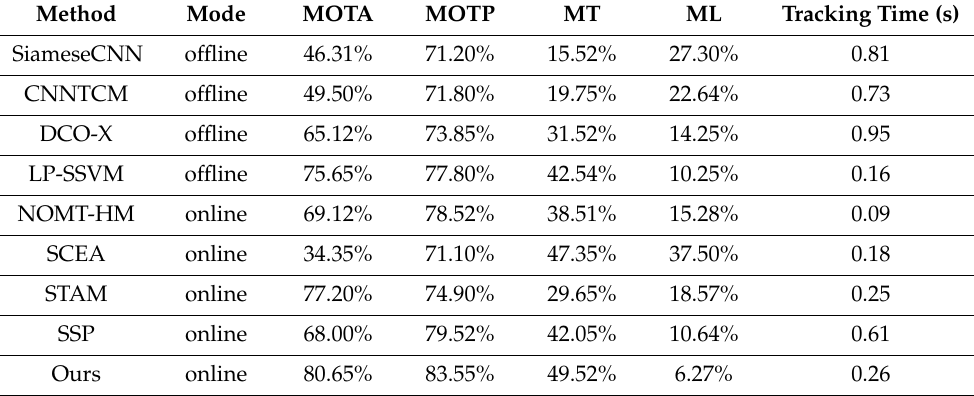
Table 4. Comparison with state-of-the-art methods on the ATTD tracking testing set.